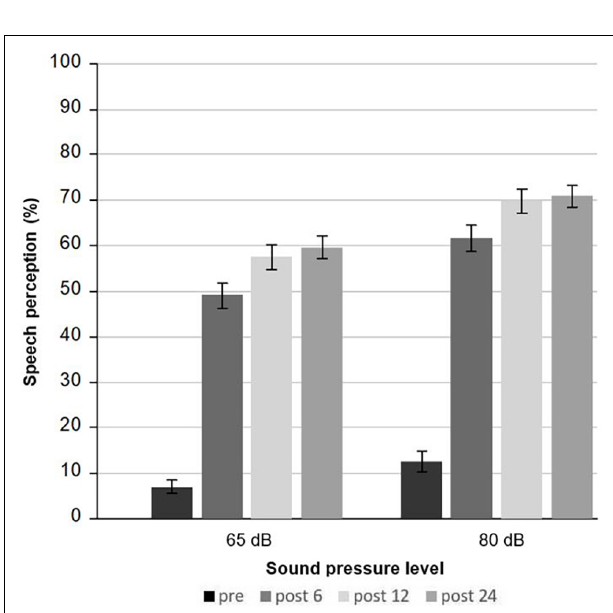
FIGURE 3 | Mean monosyllabic speech understanding at 65 and 80 dB assessed by the Freiburg monosyllabic speech test preoperatively, and 6, 12, and 24 months after cochlear implantation.